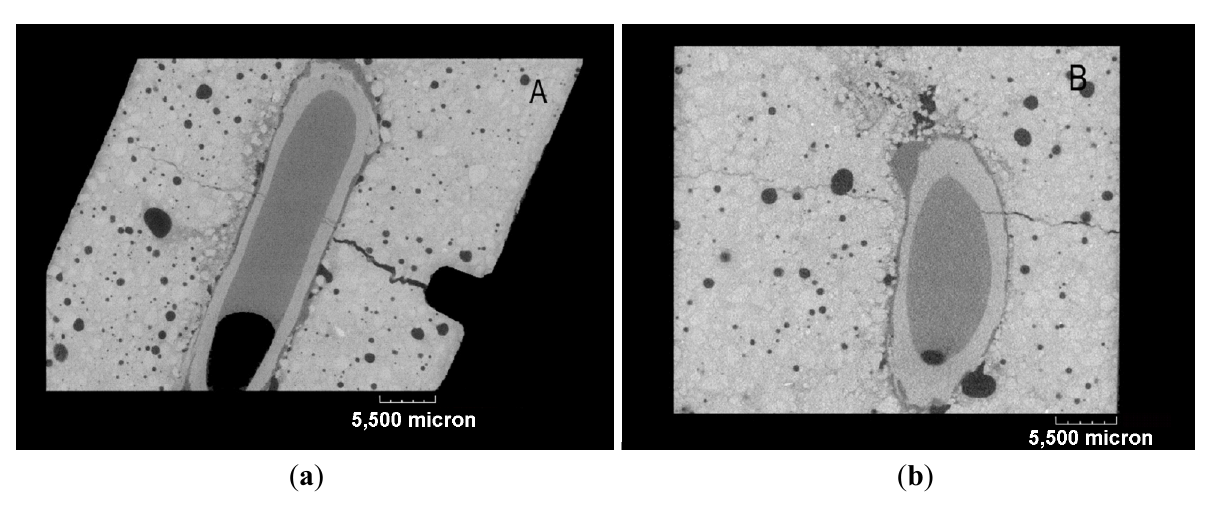
Figure 18. Cross-sections: ( a ) Section Plan A. ( b ) Section Plan B. In both of the sections, cracks crossing the cementitious matrix and the maccherone are clearly visible, as well as the sodium silicate that partially fills the gap between the crack surfaces and the amount of residual healing agent inside the tubular capsule. In the cross-sections, deep-dark colors indicate voids, medium-dark colors indicate liquids and light colors indicate solid